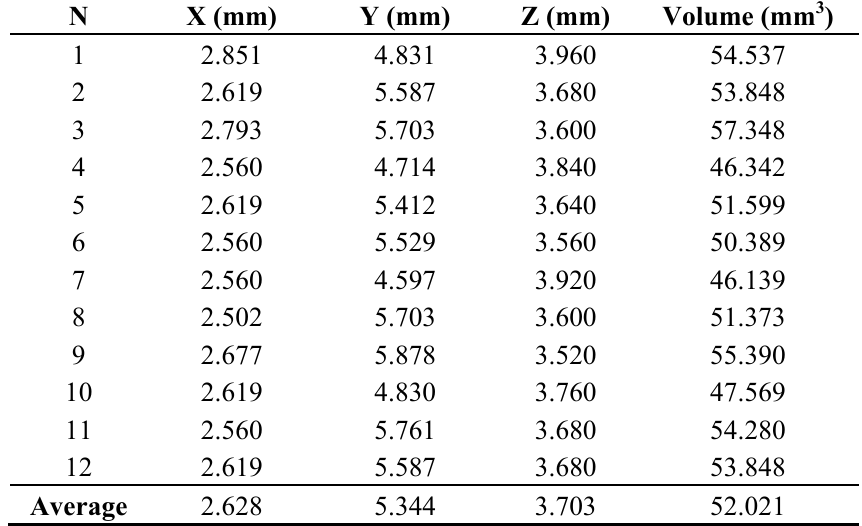
Table 1. The average volume of the fluorophore space in the LED (N =